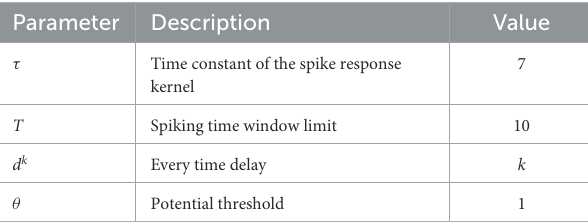
TABLE 2 Empirical settings of some parameters in all